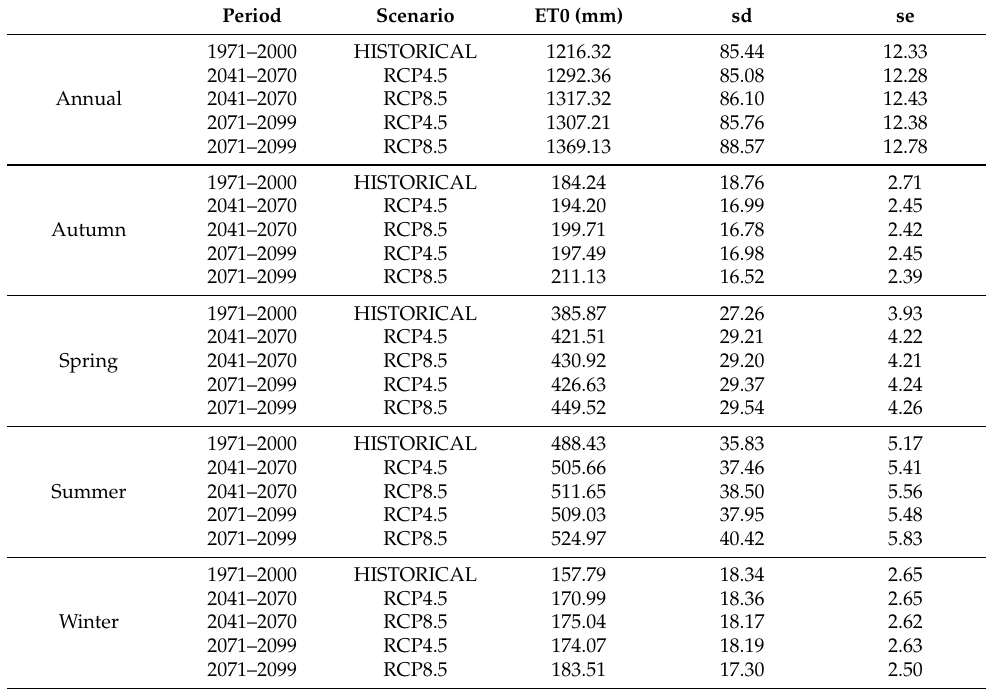
Table A4. Summary of annual and seasonal ET 0 ( n = 48 weather stations by period and